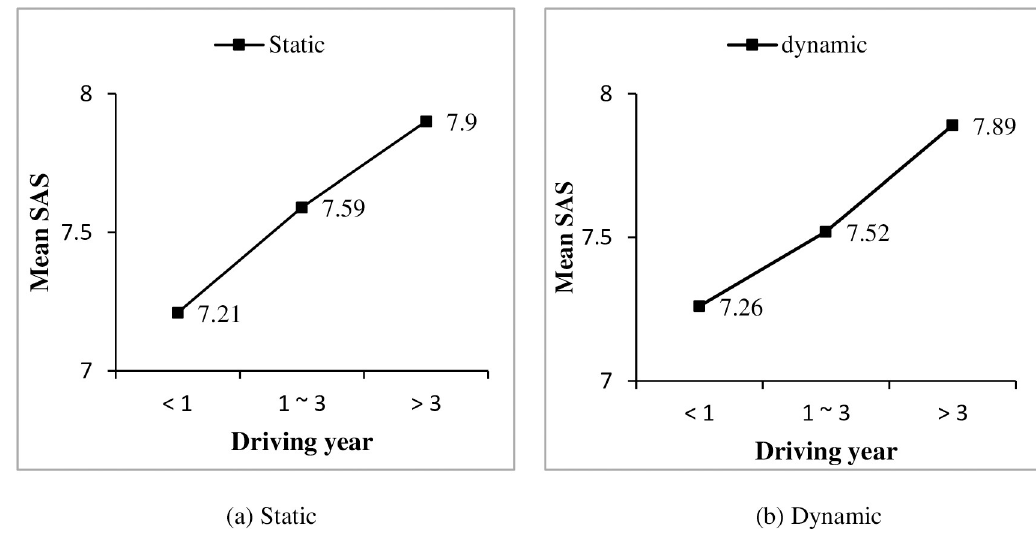
Fig 2. Effect of driving year on self-assessment scores (SAS) under different driving year conditions.